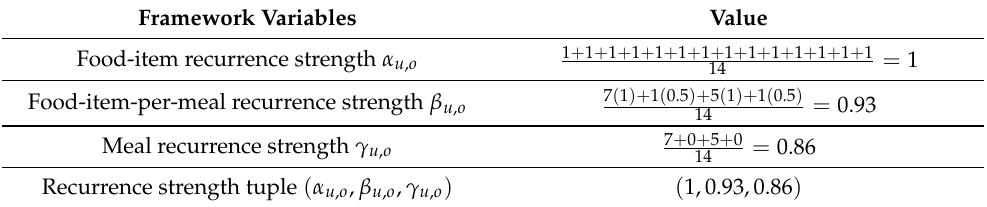
Table 2. Cont. Framework Variables Value Food-item recurrence strength α u , o = 1 Food-item-per-meal recurrence strength β u , o Meal recurrence strength γ u ,